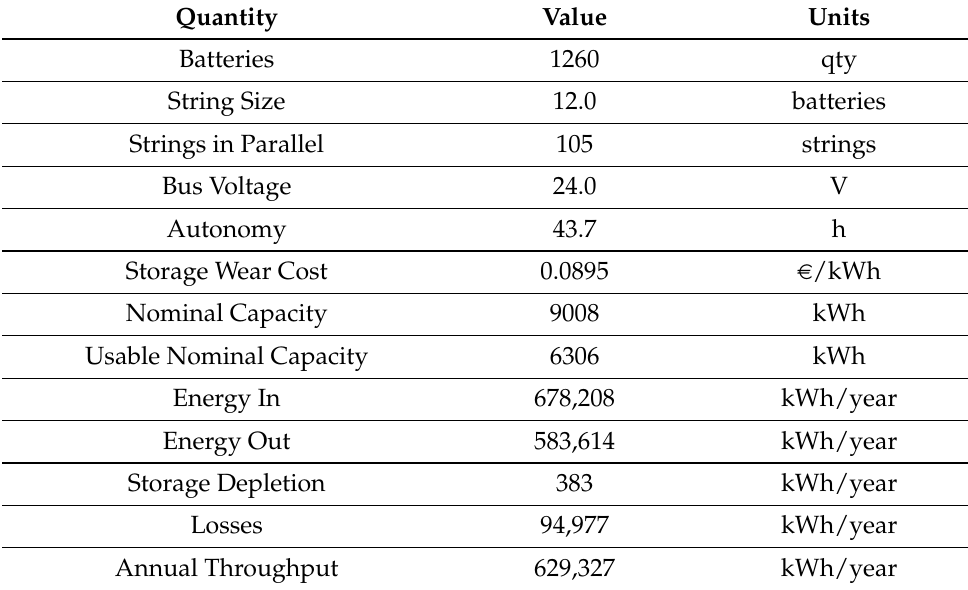
Table 27. Battery Scheme Simulation Results Case 1 Scenario 3.